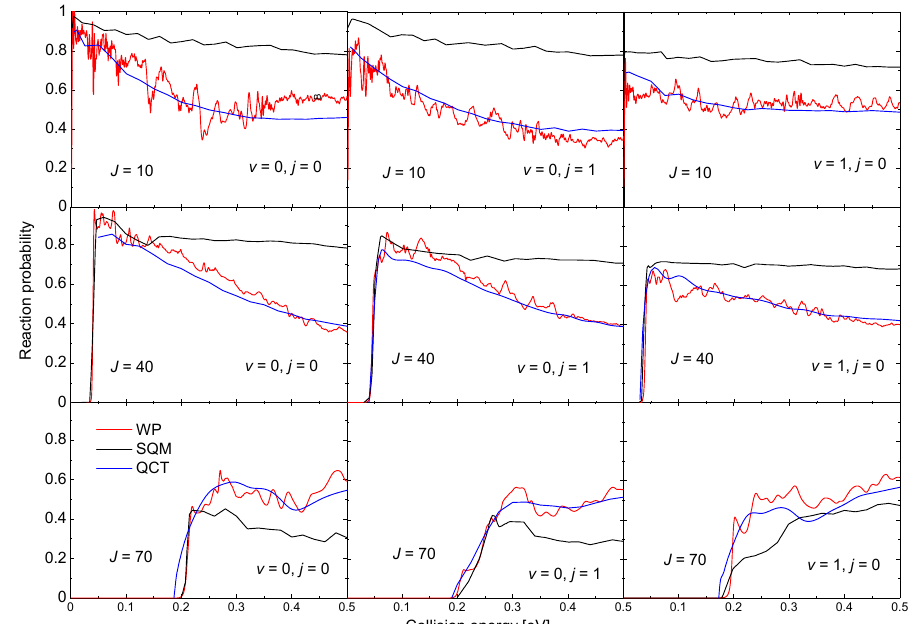
Figure 9. Reaction probabilities as a function of the collision energy (in eV) for the Ne + HeH + ( v , j ) → He + NeH + reaction for v = 0, j = 0 ( left panels ), v = 0, j = 1 ( middle panels ) and v = 1, j = 0 ( right panels ) for different values of the total angular momentum: J = 10 (top panels); J = 40 ( second row panels ) and J = 70 ( bottom panel ). Comparison of WP (red lines), SQM (black lines), and QCT (blue lines) results adapted from the work in [63].